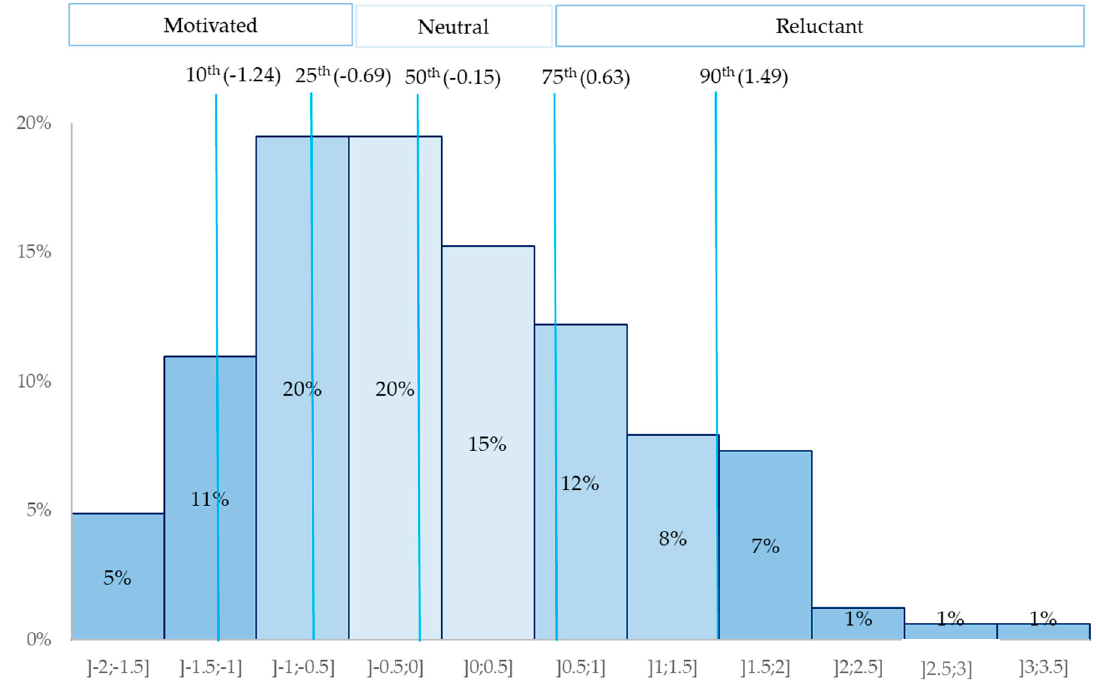
Figure 1. Distribution of respondents according to the reluctance score ( n = 164).